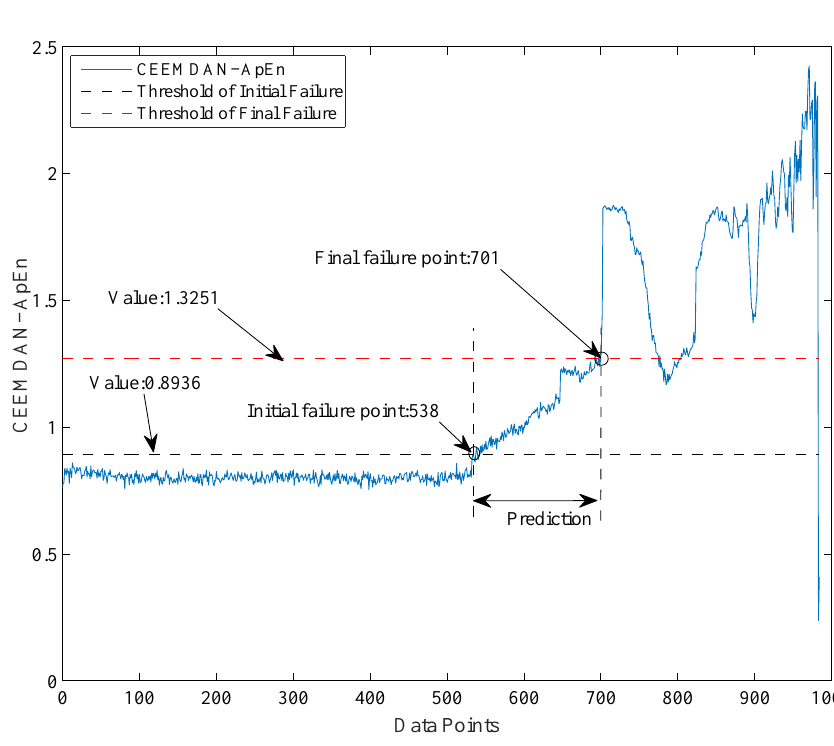
Figure 7. The degradation curve based on